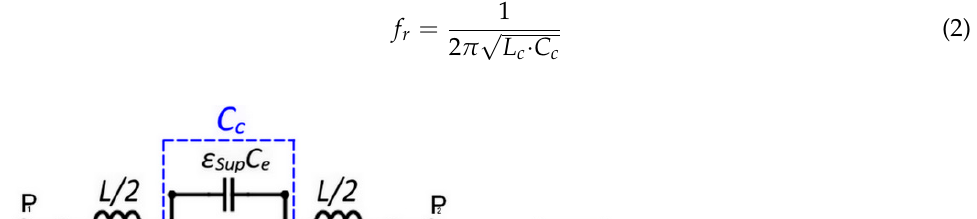
Table 2. Resonant frequencies, S 21 (dB) magnitudes, and dielectric constants for different fat layer thicknesses.